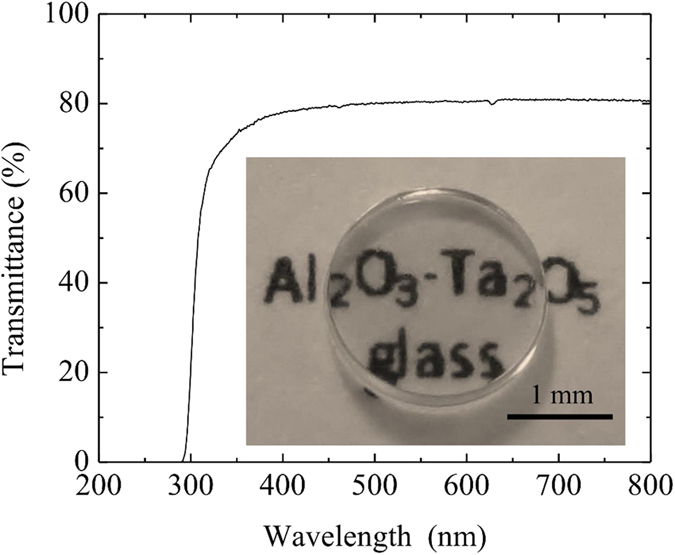
Transmittance spectrum of the 54Al2O3-46Ta2O5 glass in the UV/vis region. The inset picture shows the glass sample used for the transmittance experiment.